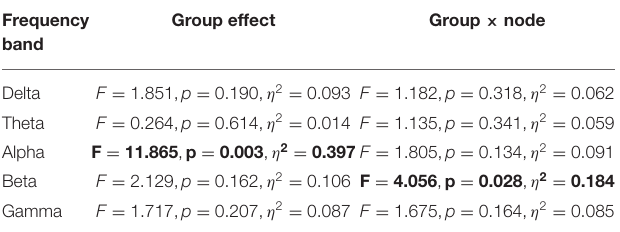
TABLE 3 | Results of mixed-design ANOVA of PLI node degree comparing high- and low-creativity groups in each frequency band, with age and IQ as covariates.